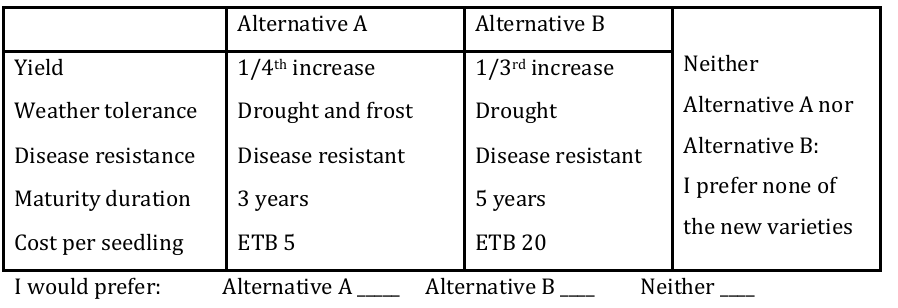
Figure 1. Example of a choice card as it appeared in the questionnaire in the final survey. The “Neither A nor B” alternative to the right is the opt-out